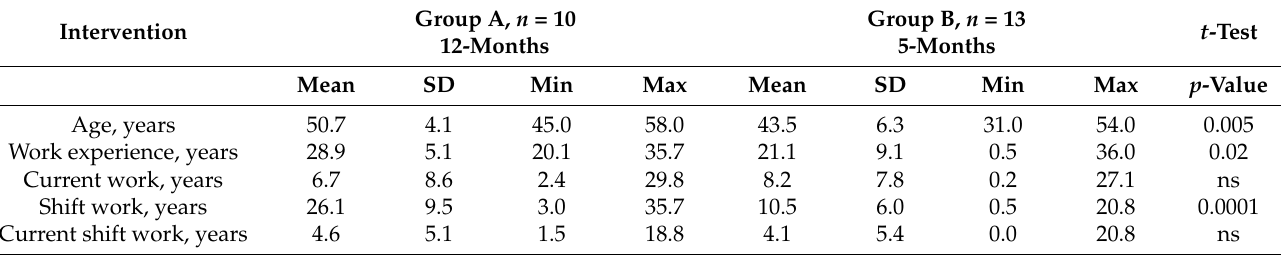
Table 1. Characteristics (mean, SD, minimum, maximum) of the subjects in baseline, n =